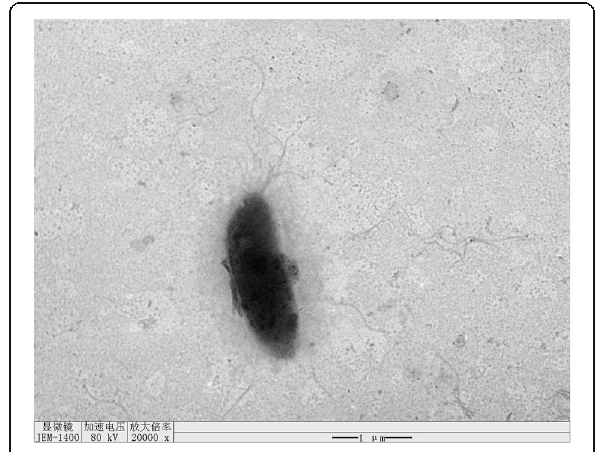
Fig. 2 Images of A. paucihalophilus TH1 – 2 T using transmission electron